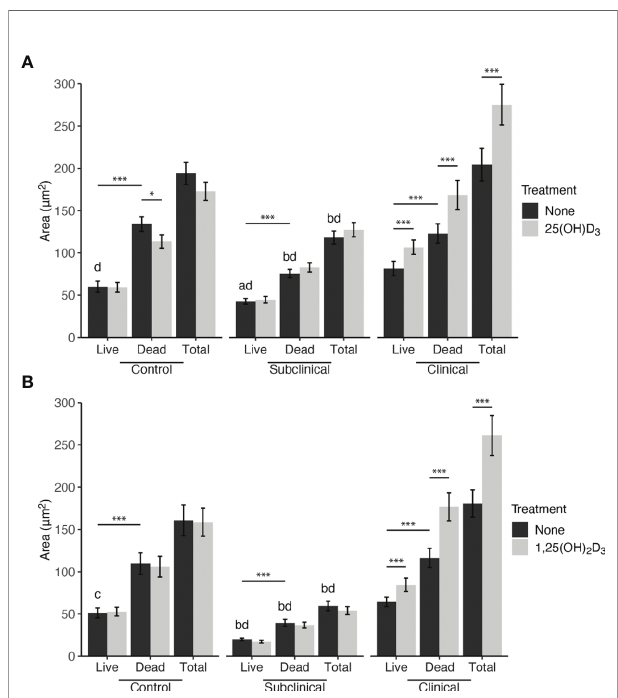
FIGURE 1 | Mean fl uorescence area of Mycobacterium avium subsp. paratuberculosis (MAP) present within monocyte-derived macrophages (MDMs) cultured from naturally infected dairy cattle (subclinical n=8, clinical n=8, and noninfected controls n=8). Peripheral blood mononuclear cells (PBMCs) were cultured 5-6 days to generate MDMs, pre-treated with vitamin D 3 as detailed in methods, then incubated 24 hrs with live MAP at 10:1 MOI (A) ± 25(OH)D 3 or (B) ± 1,25(OH) 2 D 3 . Live and dead MAP were determined using SYTO 9 and propidium iodide, respectively. Data are presented as the mean ± SE. Intra-status comparison signi fi cance levels are *< 0.05, **< 0.01, ***< 0.001. Intra-viability comparisons against the control group are a < 0.01, b < 0.001 and intra-viability comparisons against the clinical group are c < 0.05 and d <